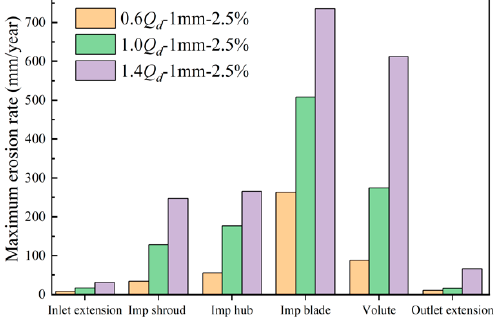
Figure 11. Curves of the erosion rates on the impeller blade and volute with the varying particle concentration under different working flow rates.